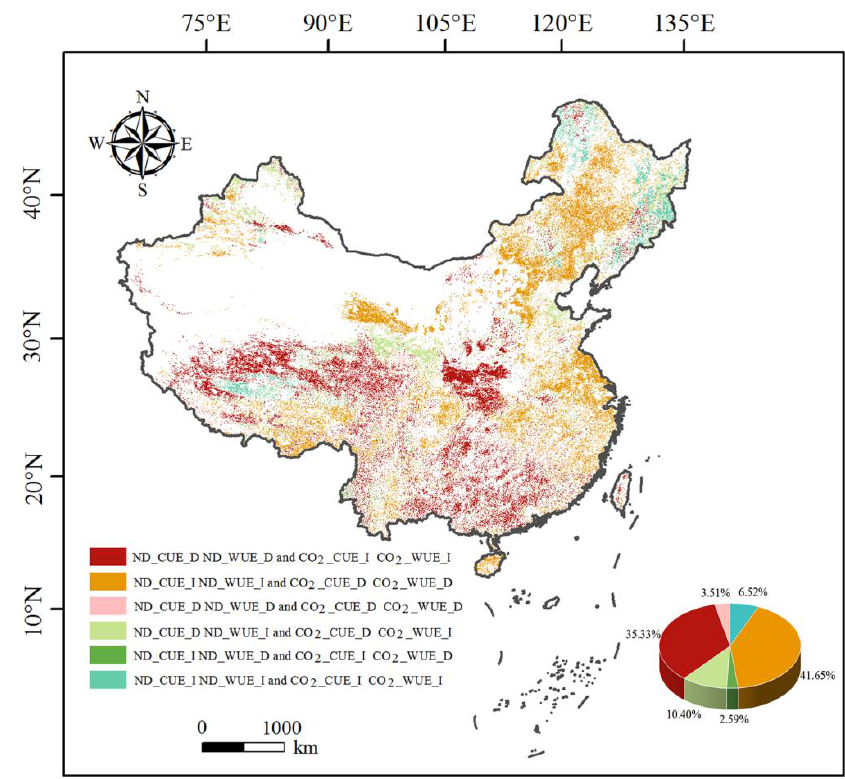
Figure 9. Interactive effects of ND and CO 2 on CUE and WUE. ND_CUE_D means ND decreases CUE, ND_WUE_D means ND decreases WUE, CO 2 _CUE_I means ND increases CUE, CO 2 _WUE_I means ND increases WUE.